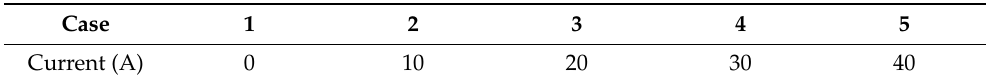
Table 3. Test scheme.